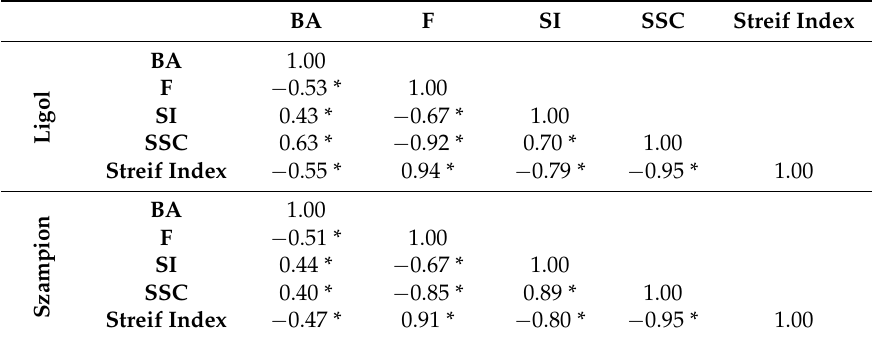
Table 3. Pearson’s correlation coefficient matrix between maturity indices and biospeckle activity (BA) evaluated for both cultivars separately. * means correlation is significant at p <